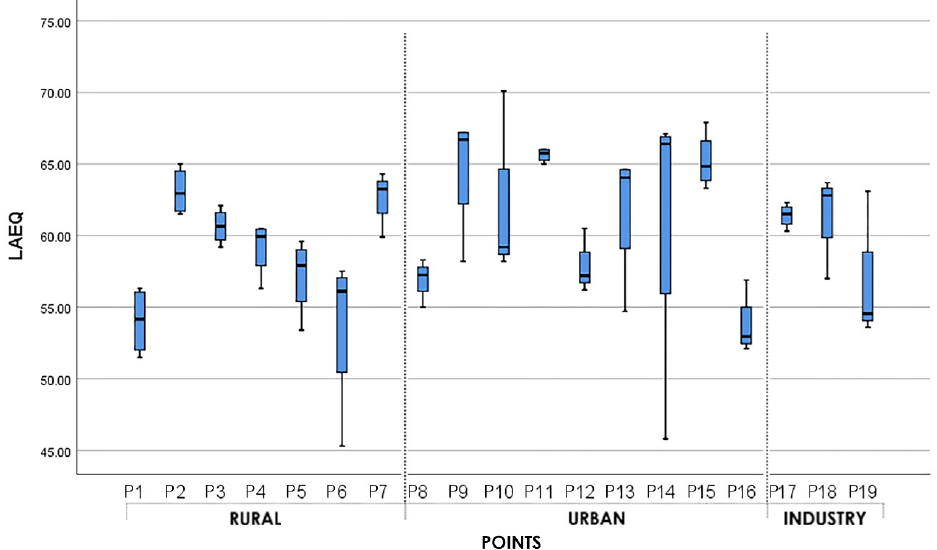
Figure 3. Sound range distribution of three zones.